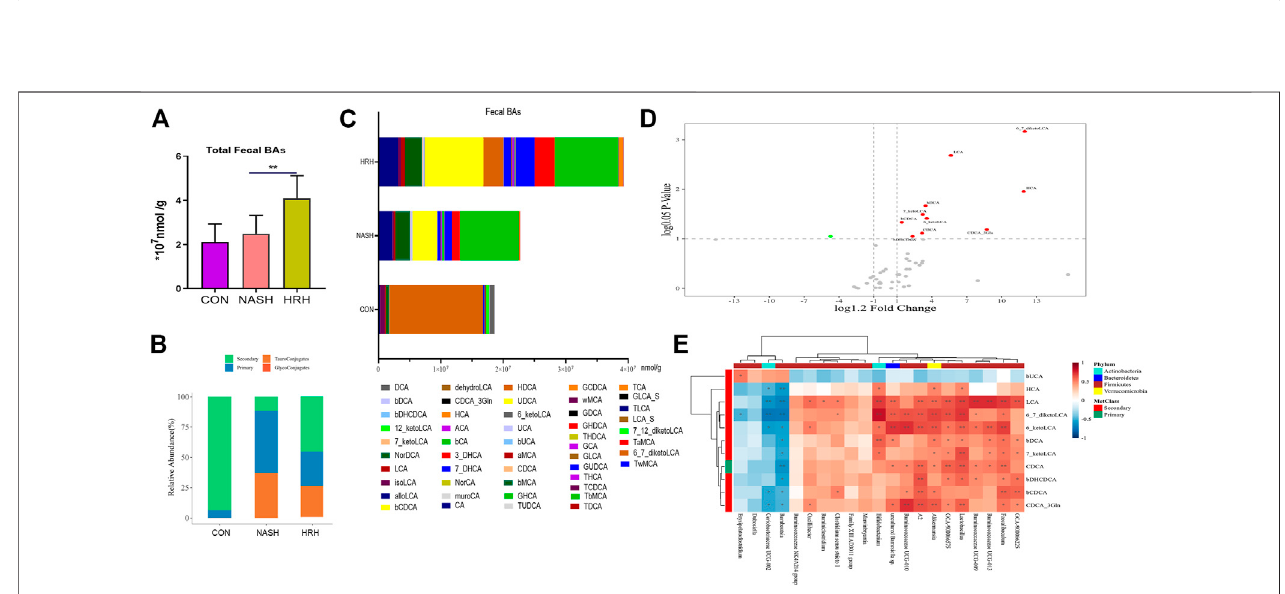
FIGURE 4 | HZRG enhances fecal BA excretion. (A) The total fecal BA concentration; (B) The alteration of BA classi fi cation; (C) Fecal BA pro fi le; (D) Volcano plot shows the change of BA species upon HZRG intervention (Red-increase, green-decrease); (E) Spearman correlation analysis of the relative abundance of microbial species and the BAs. Data are expressed as mean ± SD, n = 10 per group. * p < 0.05, ** p < 0.01between groups.